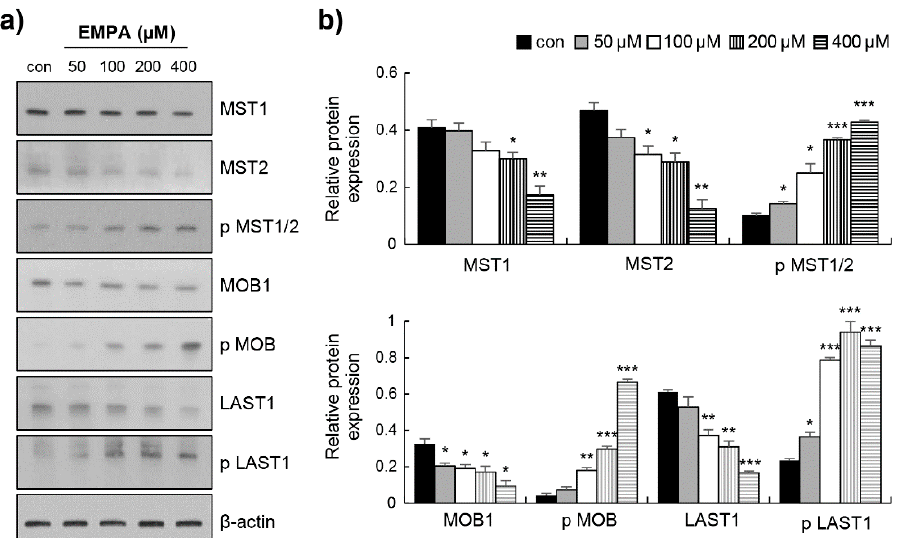
Figure 4. Empagliflozin decreased Yes ‐ associated protein (YAP) expression in LX ‐ 2 cells. ( a ) The representative protein expression of YAP and phospho ‐ YAP was determined using Western blot. ( b ) Quantitation and normalisation of phospho ‐ YAP to total YAP or total YAP to β‐ actin from a. ( c ) The relative expression of cyr61 , cTGF , and AREG was determined via RT ‐ PCR. Data are expressed as means ± standard deviation of three independent experiments. * p < 0.05, ** p < 0.01, and *** p < 0.001 compared to the control.